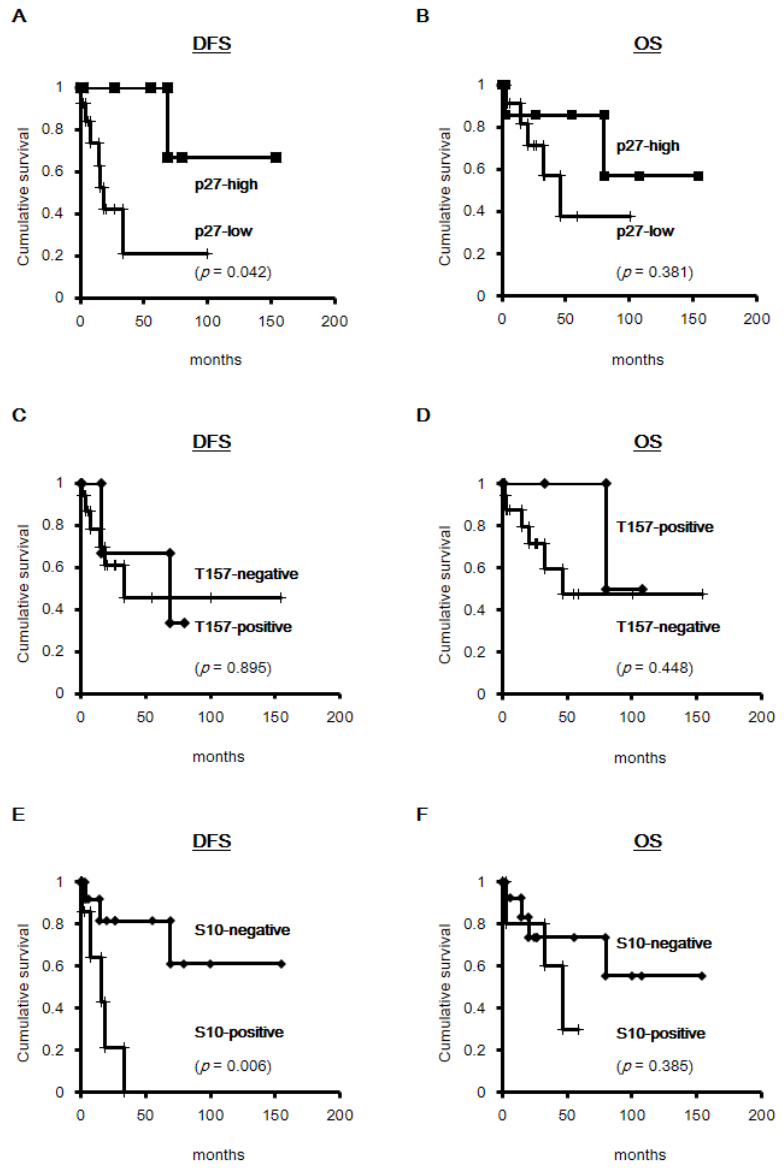
Figure 4. Kaplan-Meier curves for disease-free survival (DFS) and overall survival (OS) in HCC patients with NASH. ( A and B ) DFS and OS curves for patients according to p27 expression (p27-high, high-p27 expressers; p27-low, low-p27 expressers); ( C and D ) DFS and OS curves for patients according to phospho-p27 (T157) expression; ( E and F ) DFS and OS curves for patients according to phospho-p27 (S10) expression. p -values were obtained by the log-rank